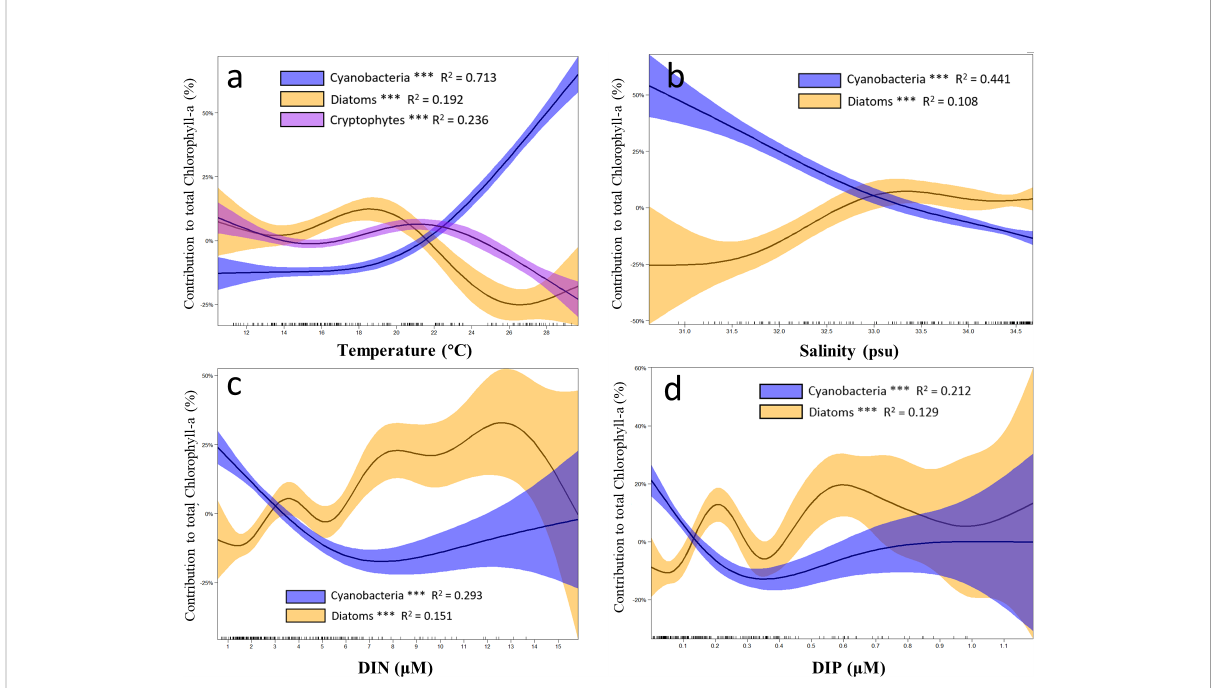
FIGURE 9 Results of the generalized additive models (GAMs) describing the contributions of major phytoplankton to chlorophyll- a with environmental factors in the SCWK from 2018 to 2020. (A) Changes in the contributions of cyanobacteria, diatoms, and cryptophytes with temperature. Changes in the contributions of cyanobacteria and diatoms with (B) salinity, (C) dissolved inorganic nitrogen (DIN), and (D) dissolved inorganic phosphorus (DIP). The contributions of different phytoplankton groups to chlorophyll- a are plotted as differences between concentrations and mean values ( Y -axis). Solid lines with signi fi cant relationships (asterisks on the phytoplankton group legends, p < 0.001) represent smoothing lines from GAMs, and shaded areas indicate 95% con fi dence intervals. The inward tick marks on the X -axis show data